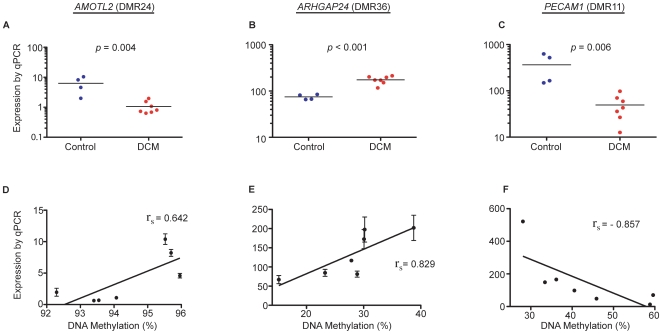
Differential DNA methylation for 3 CM-DMR correlates with differential gene expression.(A–C) Gene expression profiles for the gene corresponding to each DMR: AMOTL2, ARHGAP24, and PECAM1. Quantitative PCR was performed in a set of 11 LV samples (4 controls: C–F, 7 CM: II–VIII). QPCR experiments were performed in triplicate for each sample. ** p<0.05. (D–F) Correlation between gene expression and DNA methylation using Spearmans rank order correlation coefficient.